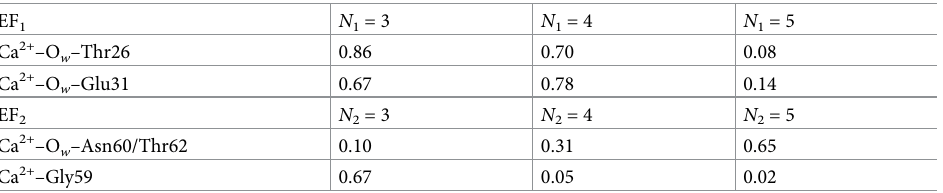
Table 1. Probabilities of non-native ligand coordination and water-bridged native ligand coordination. O w refers to oxygen in water. N α is the number of coordinated native